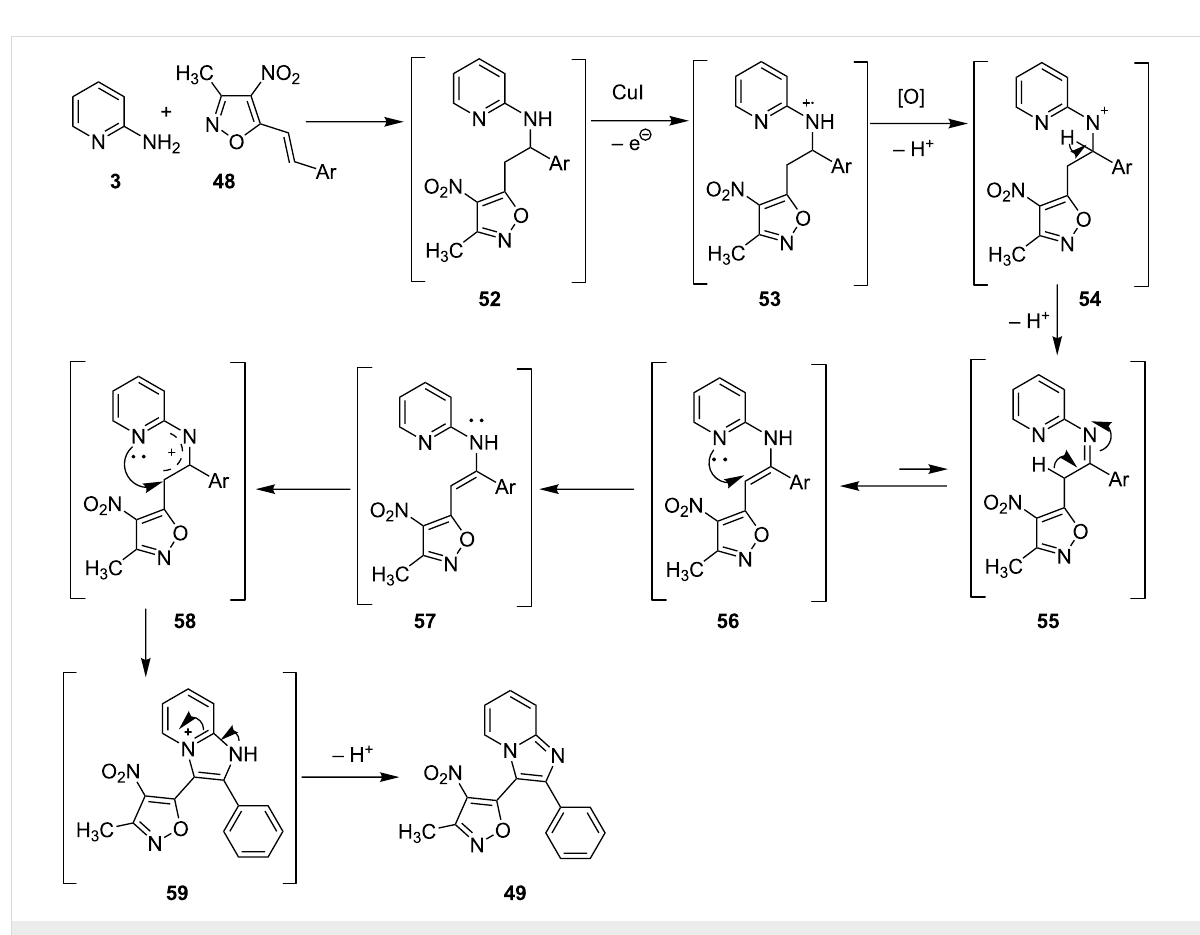
Scheme 19: A plausible reaction